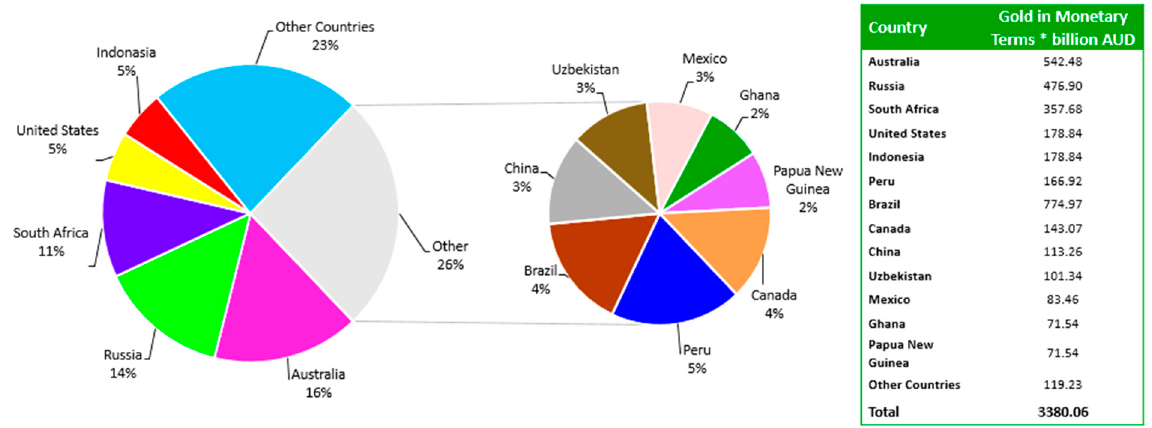
Figure 1. Global gold mine reserves in 2015. Total mine gold reserve was 56,700 metric tons whilst total monetary estimate was AUD$ 3380.06 billion [7].